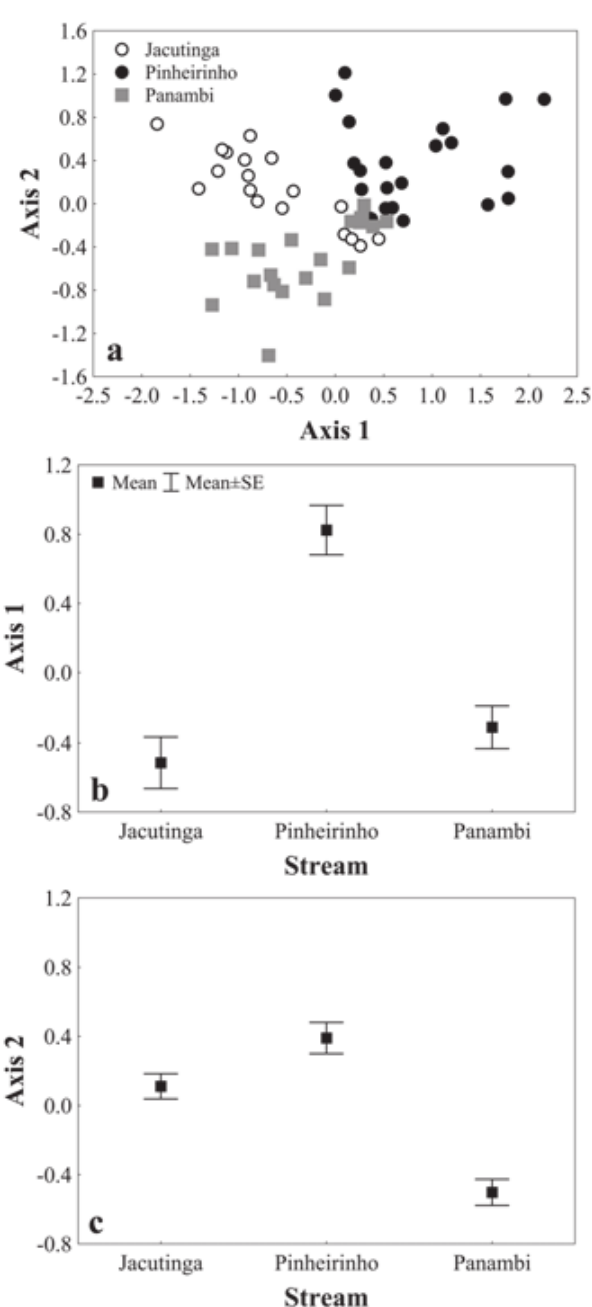
Fig. 2. Non-metric multidimensional scaling (NMDS) ordination of the fish assemblages in the streams Jacutinga, Pinheirinho, and Panambi ( a ) Axis 1 x Axis 2, and average values (± standard error) of axis scores in the NMDS ordination for streams, ( b ) axis 1 and ( c ) axis 2.